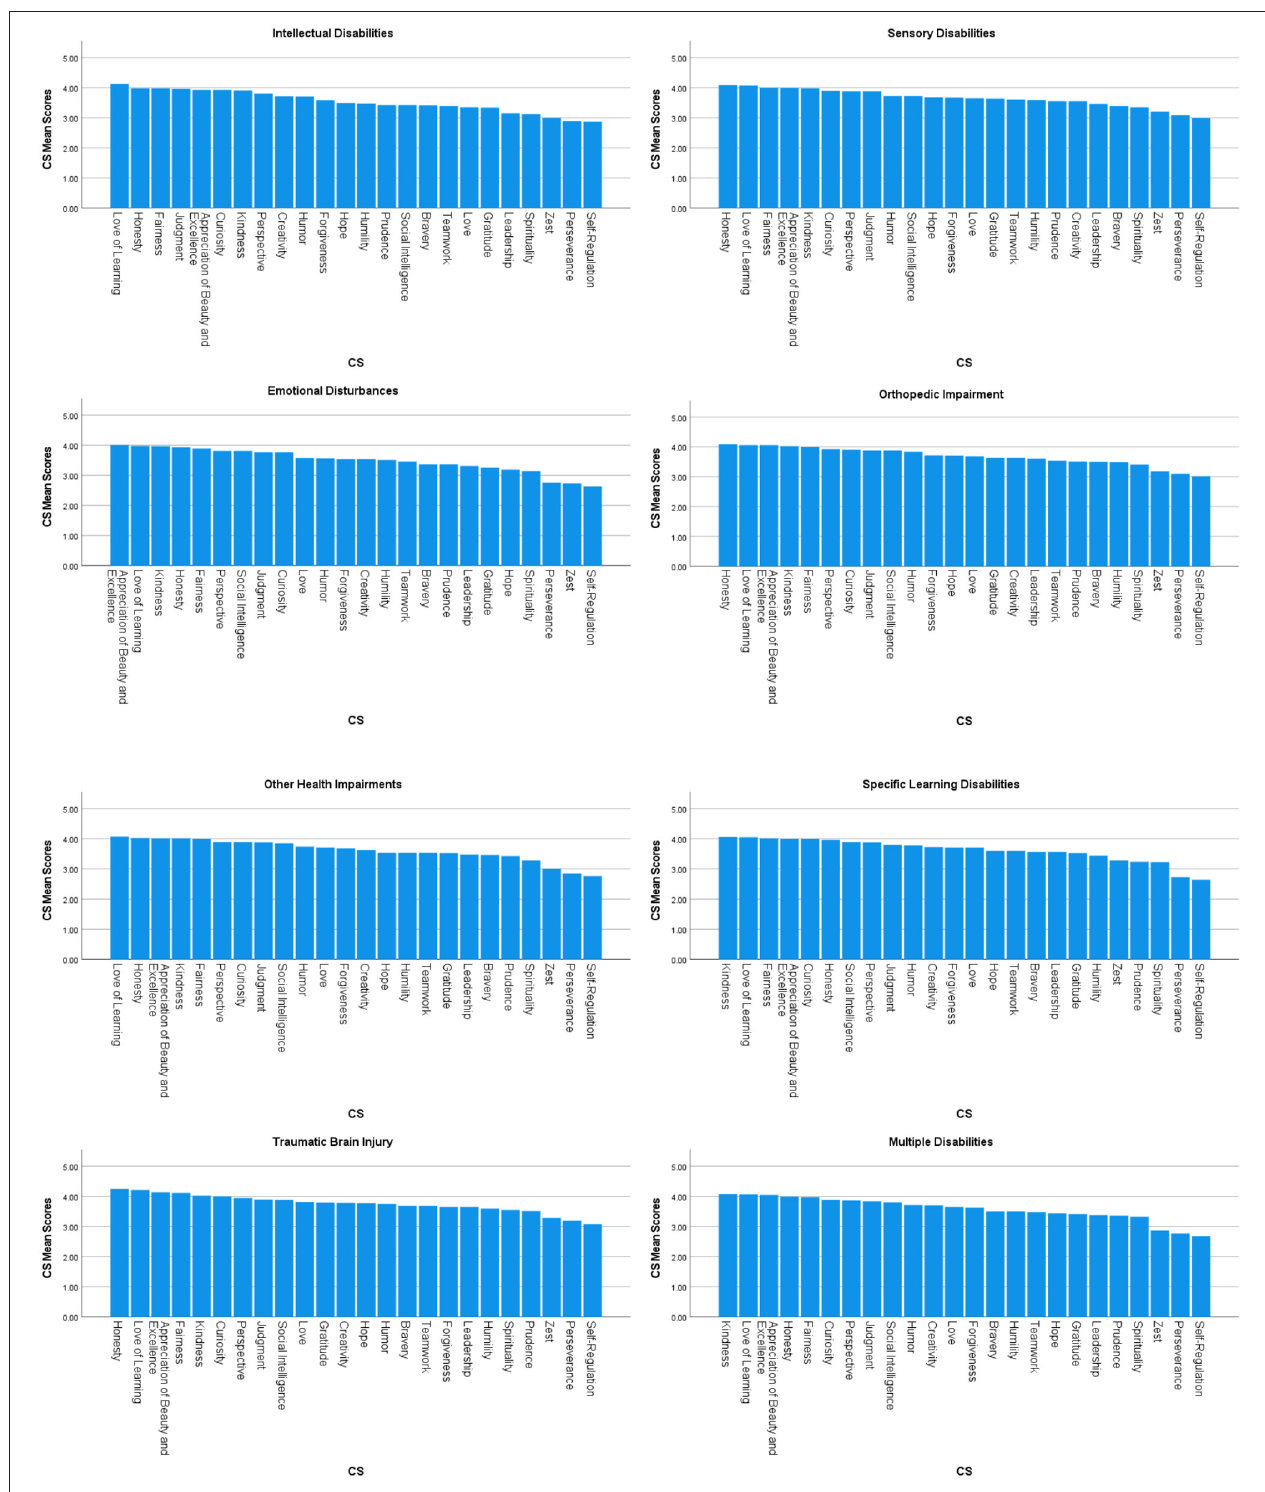
FIGURE 1 | Character strengths profiles for each disability